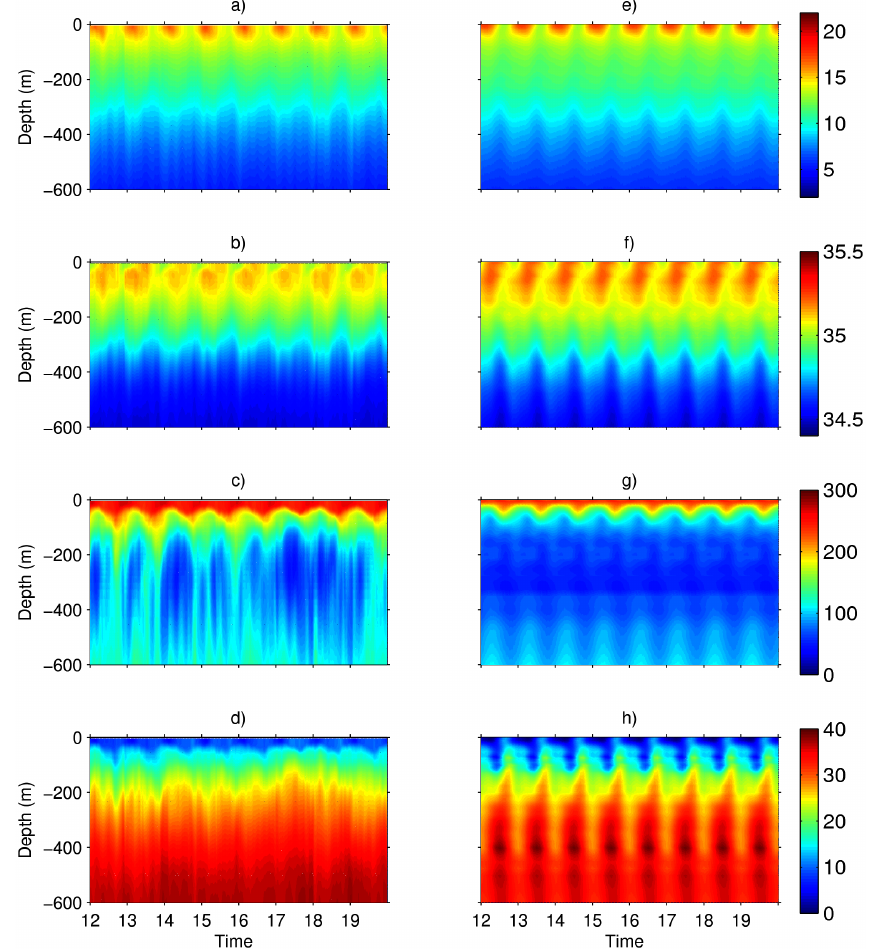
Fig. 6. Times series (last 8yr of simulation: Y12 to Y19) of temperature ( ◦ C) (a, e) , salinity (b, f) , oxygen (mmolO 2 m − 3 ) (c, g) , and nitrate (mmolNm − 3 ) (d, h) averaged over the continental shelf and slope ( ∼ 12.5–15 ◦ E) and between 22–24 ◦ S. Simulated fields are on the left side and CARS (2006, 2009) monthly climatology on the right